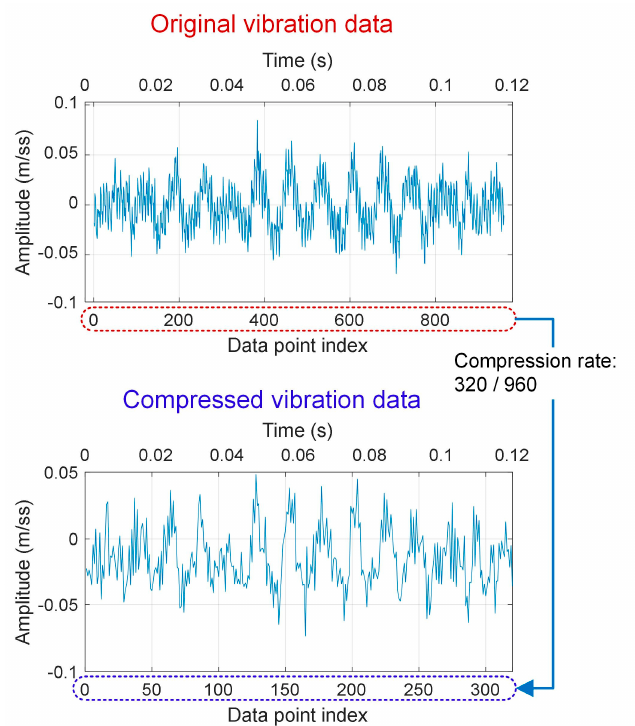
Figure 10. LGPG: Vibration data compression.